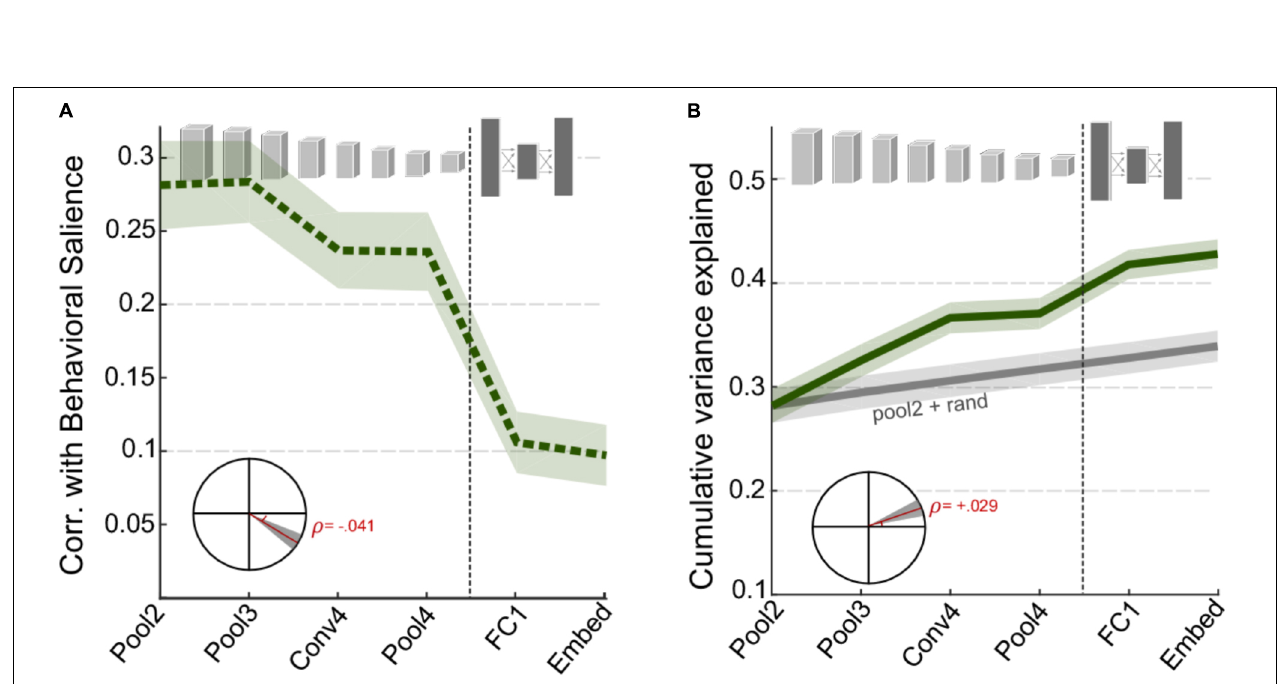
FIGURE 3 | CNN surprisal and behavioral salience. (A) Correlation between CNN activity and behavioral salience. (B) Cumulative variance explained after including successive layers of the CNN. The gray line shows a baseline level of improvement estimated by using values drawn randomly from a normal distribution for all layers beyond Pool2. For both panels, shaded areas depict ± 1 SEM. Insets show the slope of the trend line fitted with a linear regression, with shaded areas depicting 99% confidence intervals of the